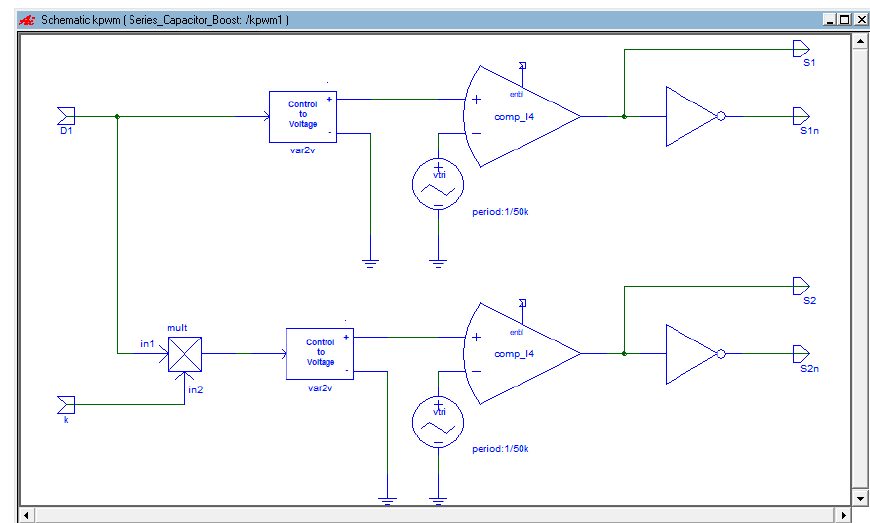
Figure 13. Implementation of the modified PWM scheme.